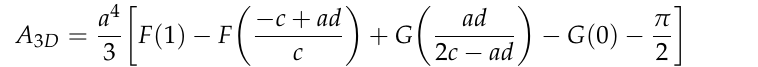
Figure 4. Three-dimensional representation of a hole and 3D surface area; definition of the parame- ters a , c, and d . The parameters a , c, and d are as follows: 𝑎 = (cid:3496) 𝐿 (cid:3043)(cid:3051) 𝐿 (cid:3043)(cid:3052) 𝑡 (cid:3047) − 𝐷 (cid:3035)(cid:3052) (2)